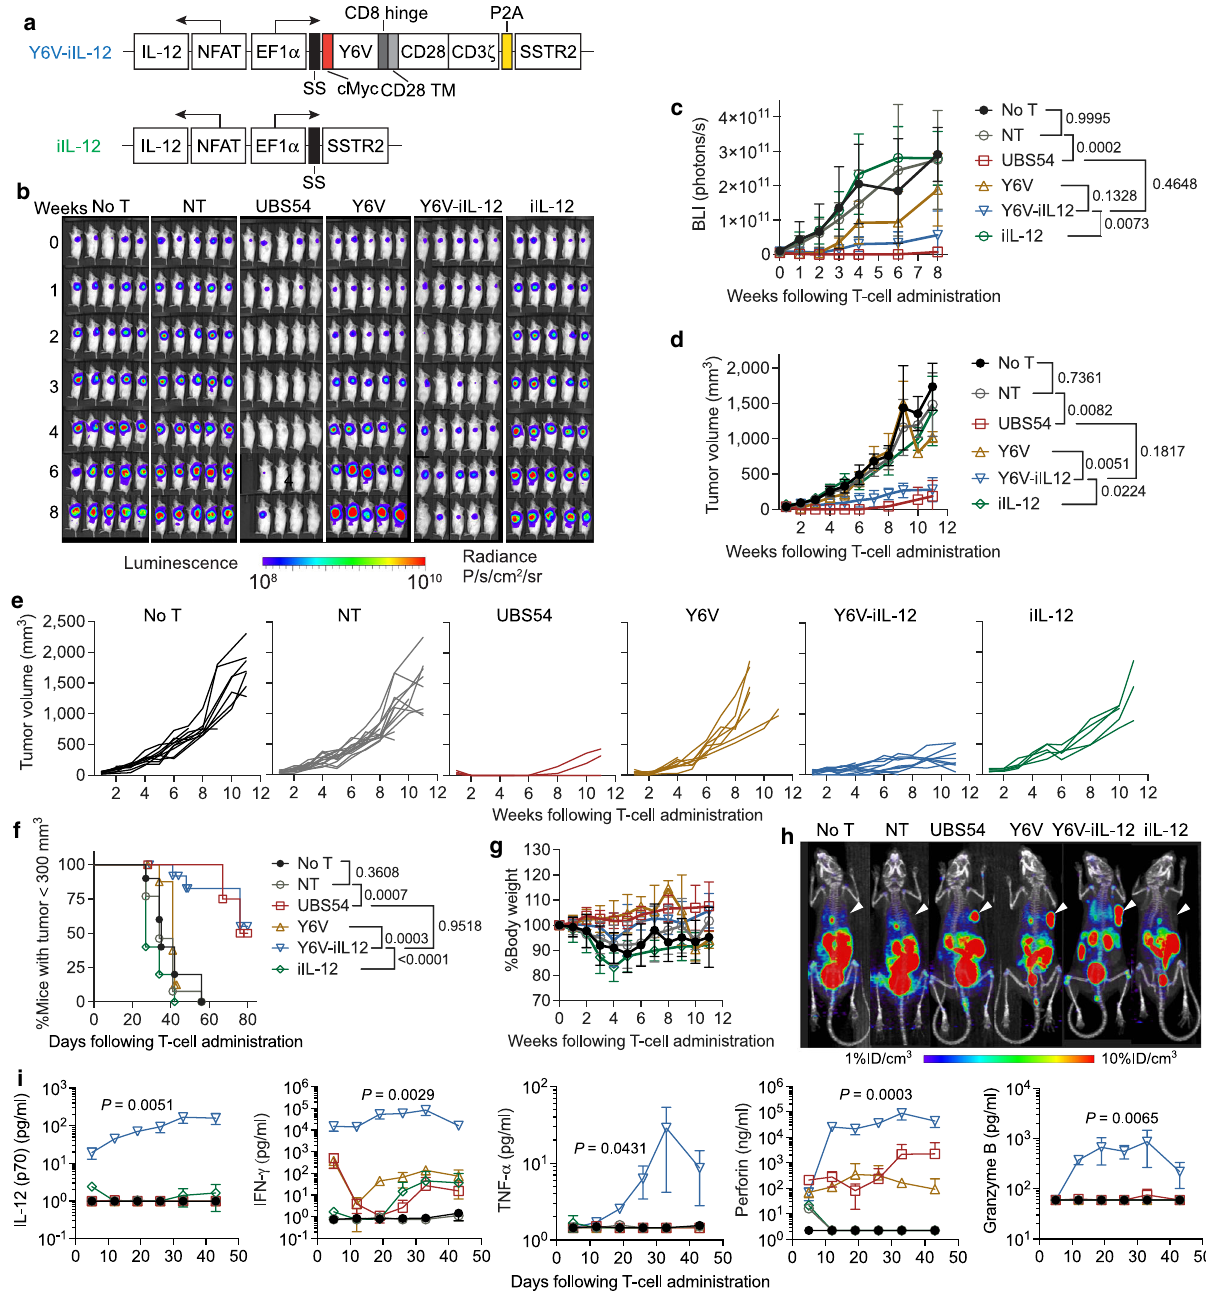
Fig. 3 | Inducible IL-12 expression increases the activity of af fi nity-tuned Y6V CAR-T cells against GC. a Lentiviral vectors encoding Y6V-iIL12 CAR and iIL-12 control construct. b – i NSG mice were inoculated with 1×10 6 SNU-638 cells sub- cutaneously. 1×10 7 non-transduced T (NT), UBS54, Y6V, Y6V-iIL12 or iIL-12 CAR- T cells were administered intravenously 7 days post-xenograft. b Representative bioluminescence images from one independent experiment ( n =5 mice/group). c Average whole-body BLI kinetics. d Average tumor volume measurements over time. Data represent mean±SD. P -values were determined by Two-way ANOVA withTukey ’ smultiplecomparisonstest. e Tumorgrowthcurvesforindividualmice. f Percentage of mice with tumors <300mm 3 . P -value was determined by log-rank (Mantel – Cox) test. g Average body weight changes relative to baseline.